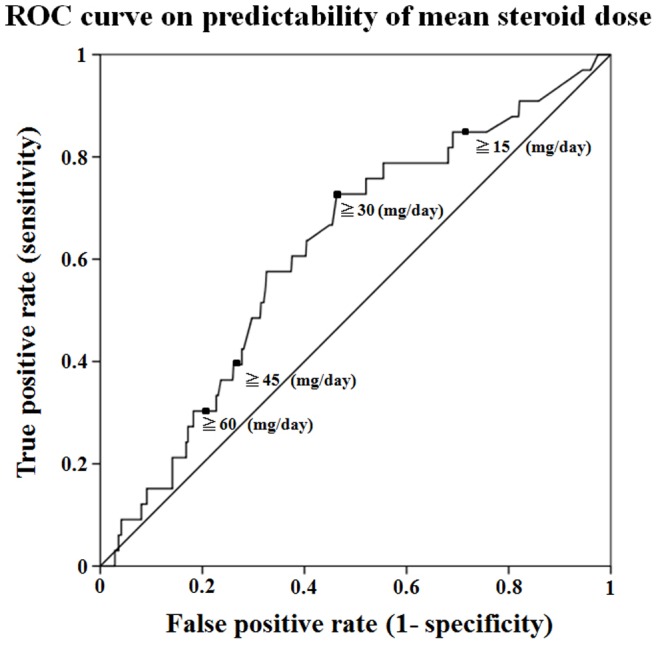
ROC curve on predictability of mean steroid dose.Receiver operating characteristics (CRC) curve for different cut-off values, as shown in the graph, of mean steroid dose to predict intracellular infections.